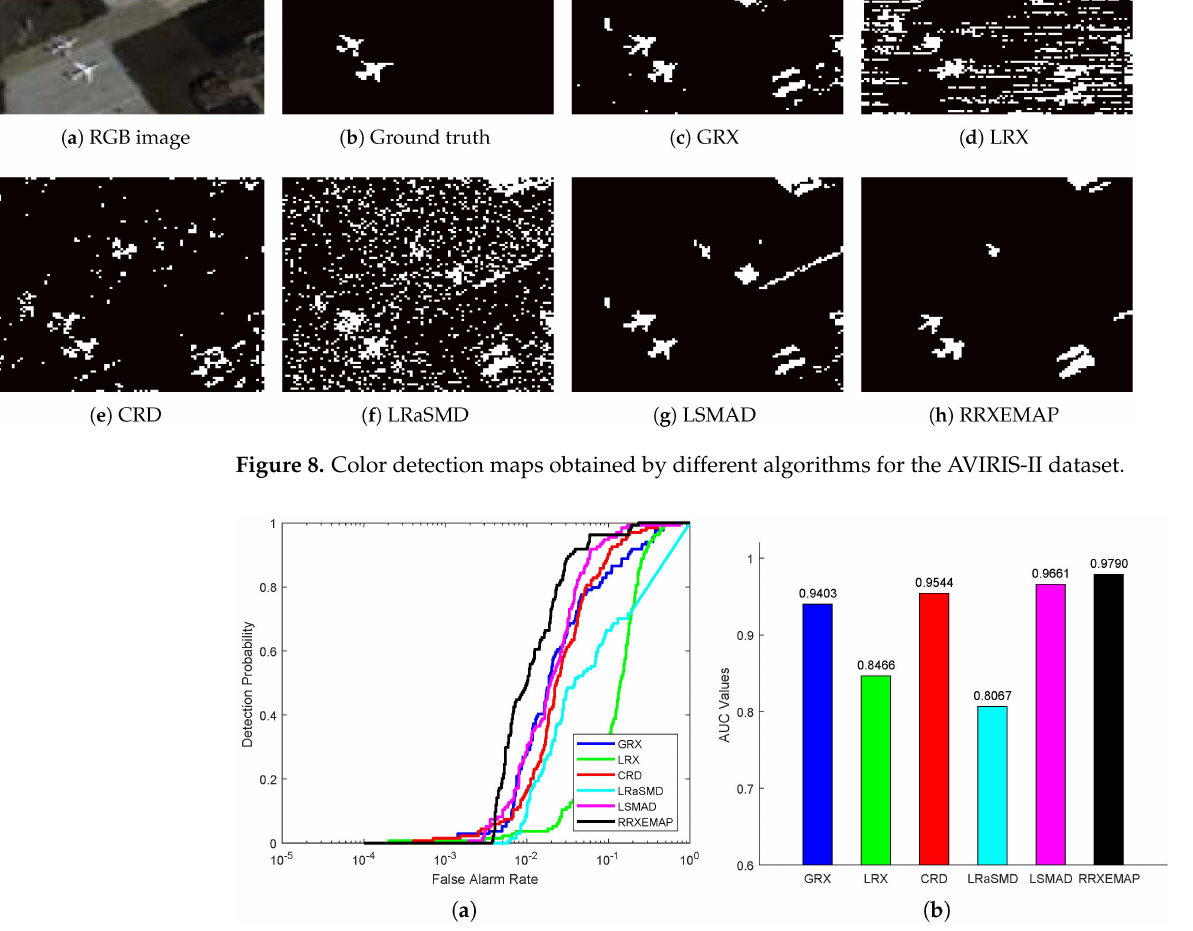
Figure 9. Detection accuracy evaluation for the AVIRIS-II dataset. ( a ) ROC curves. ( b ) AUC values. For the Cri dataset, the color detection maps of different methods are presented in Figure 10. All the detectors (GRX, LRX, CRD, LRaSMD, LSMAD and RRXEMAP) can